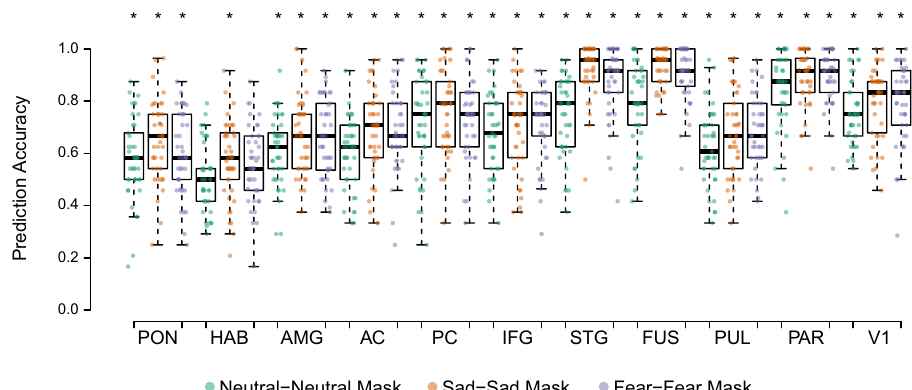
Fig. 3 MVPA classi fi cation accuracies. Comparison of MVPA classi fi cation accuracies of affective stimuli and corresponding masked stimuli conditions. Accuracies tested against shuf fl ed baseline (0.50), *( p FWE < 0.05). Whiskers: ±1.5 × interquartile range ( N = 41). AC anterior cingulate cortex, AMG amygdala, FUS fusiform, HAB habenula, IFG inferior frontal gyrus, PAR parietal, PC posterior cingulate cortex, PON pons, PUL pulvinar; P/PC precuneus/ posterior cingulate cortex, STG superior temporal gyrus, and V1 primary visual cortex.